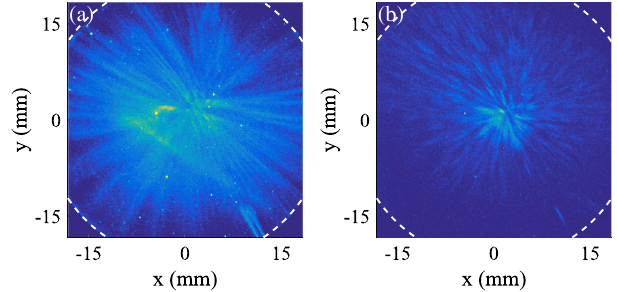
FIG. 12. Field emission images obtained on YAG 3 without a collimator (a) and with a ∅ 1 mm aperture (b). The white dashed circles represent the ∅ 44 mm YAG